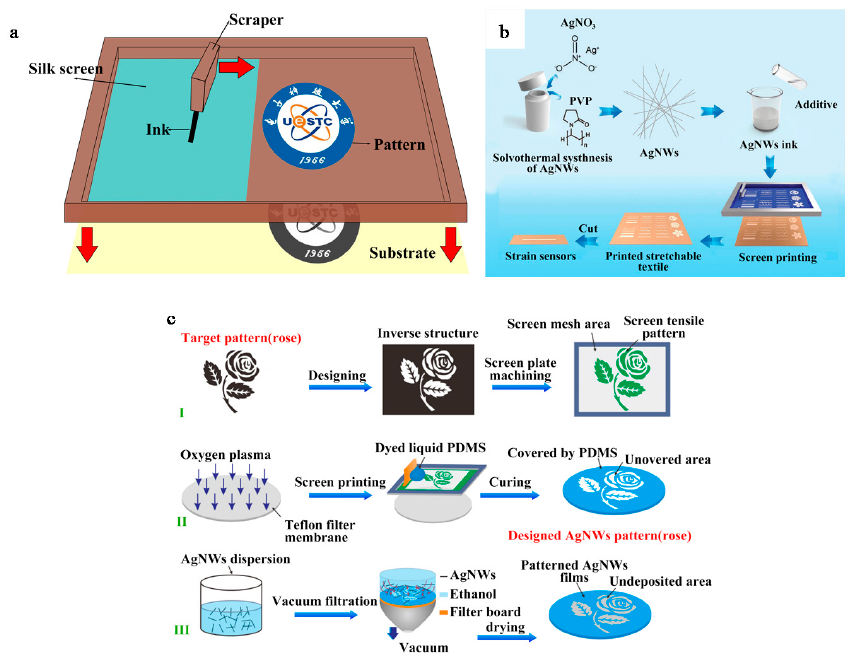
Figure 5. ( a ) Screen printing method process, ( b ) Schematic diagram of the AgNWs ink preparation